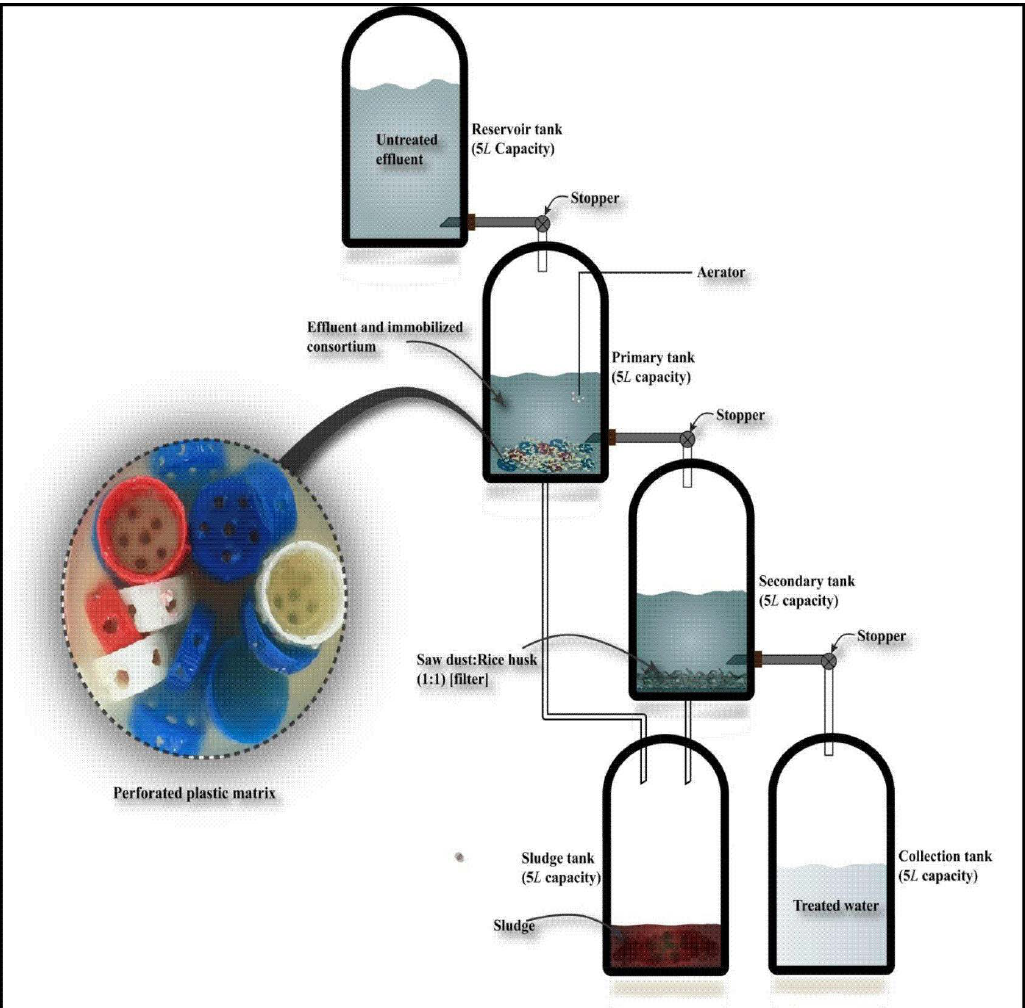
Fig. 1. Experimental set up of laboratory structured continuous scale aerobic bioreactor for the treatment of